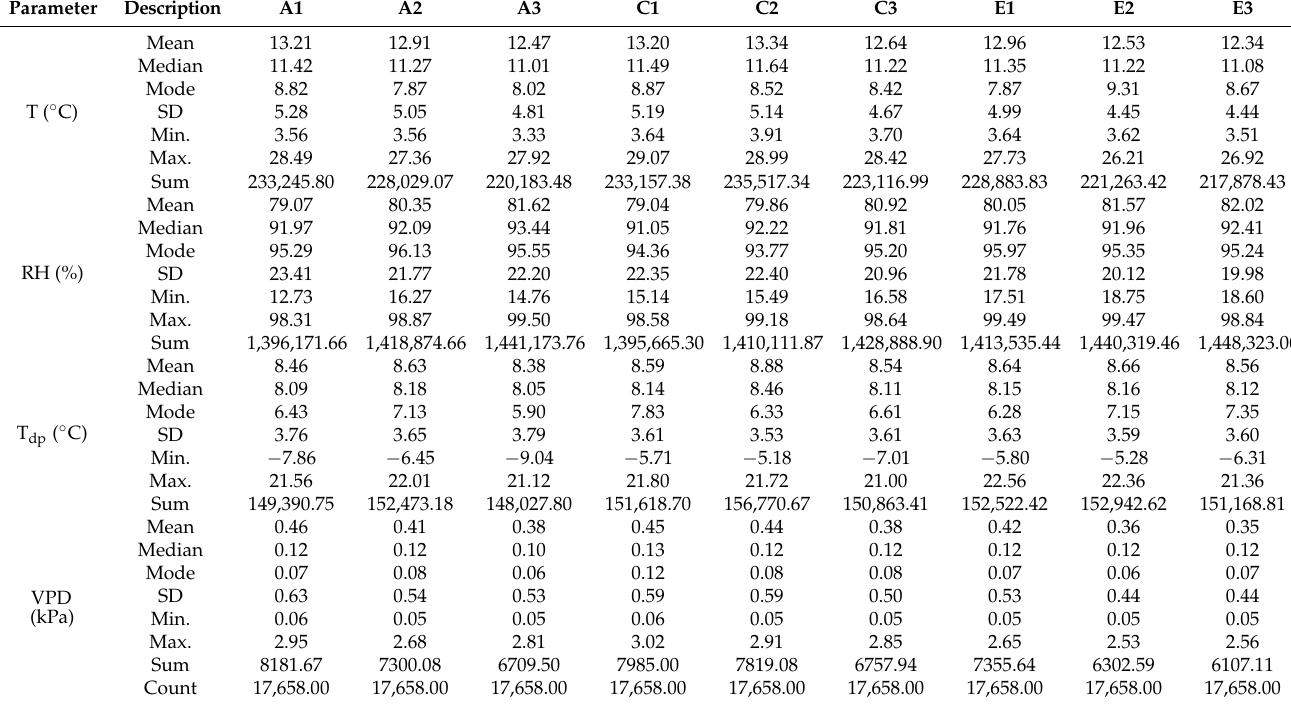
Table 2. Descriptive statistics of T, RH, T dp , and VPD distributions in DLG. SD: standard deviation; Min.: minimum; Max.: maximum. T: air temperature; RH: relative humidity; T dp : dew point temperature; VPD: vapor pressure deficit; DLG: double-layered greenhouse.